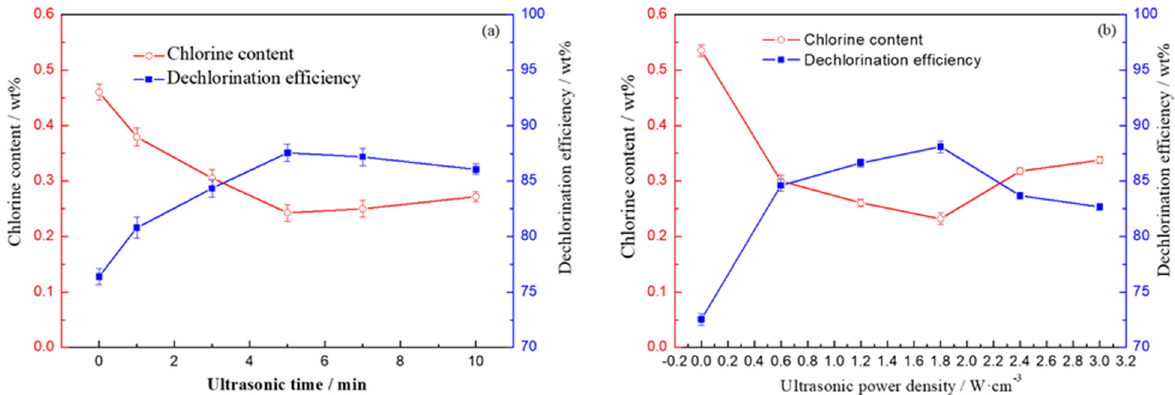
Figure 1. Influence of ultrasonic time at 60% intensity ( a ) and ultrasonic power density at 5 min ( b ) on the catalytic DC property.